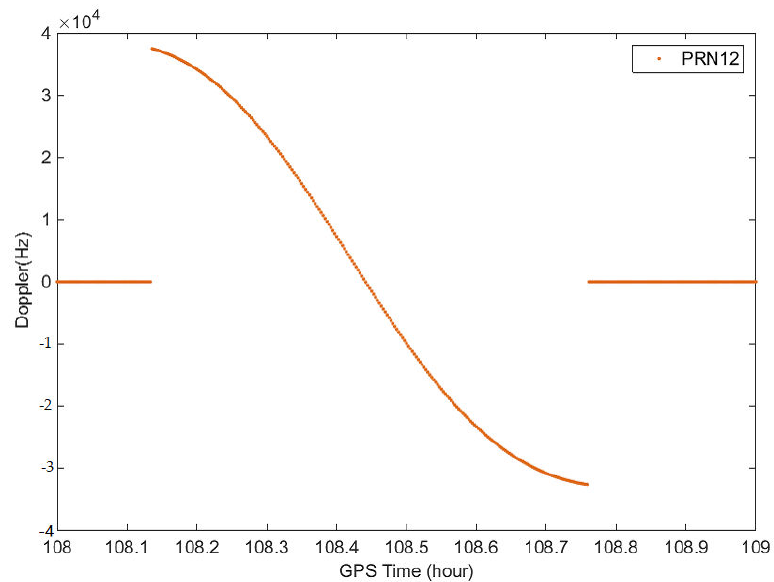
Figure 6. Doppler shift simulation of a low Earth orbit (LEO)